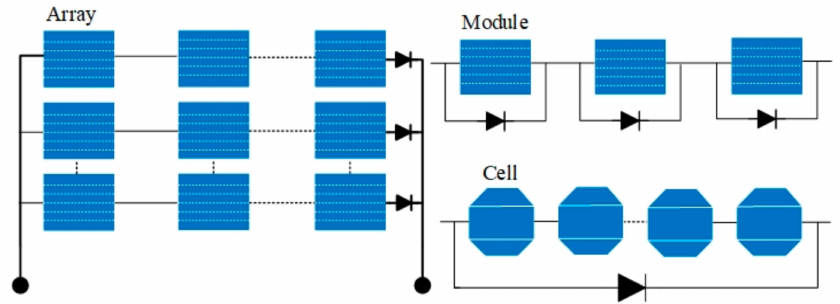
Figure 1. Componential structure of the photovoltaic (PV) array.